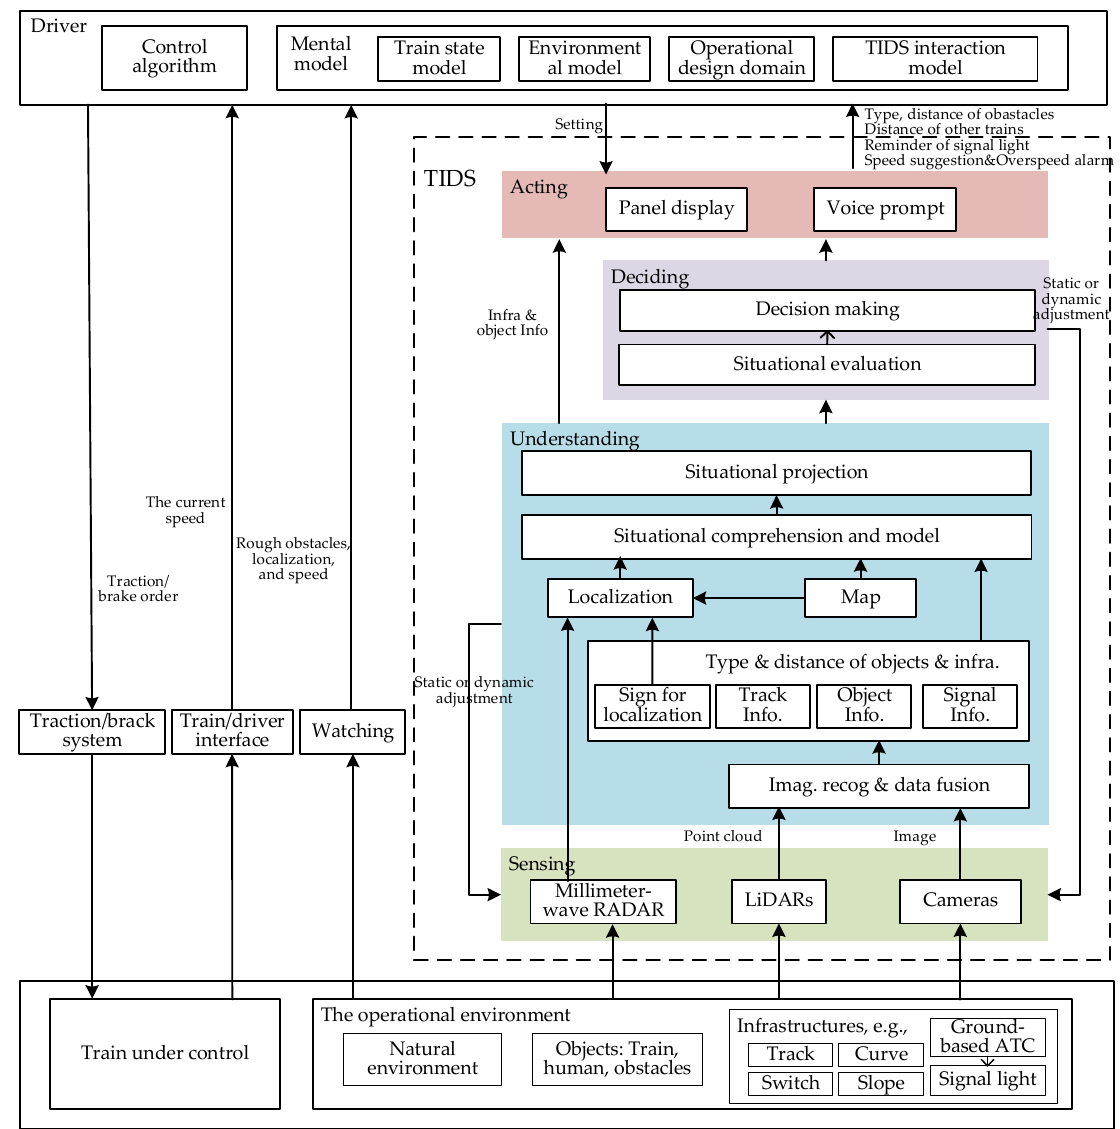
Figure 4. The control structure of the overall driving